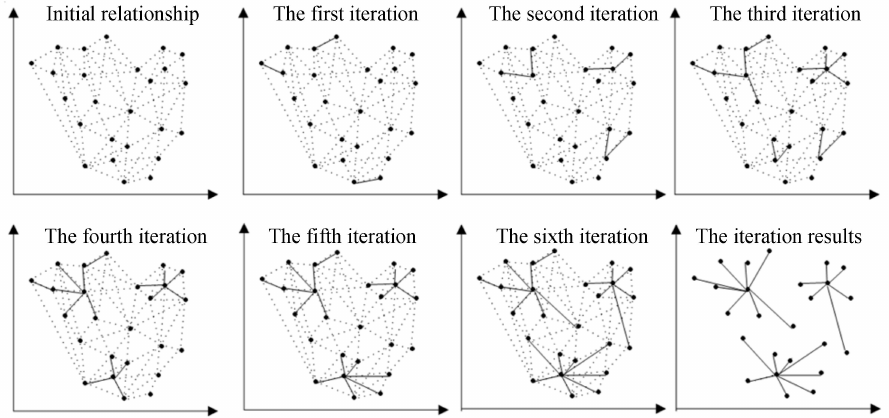
Figure 6. Image grouping principle of graph based AP clustering